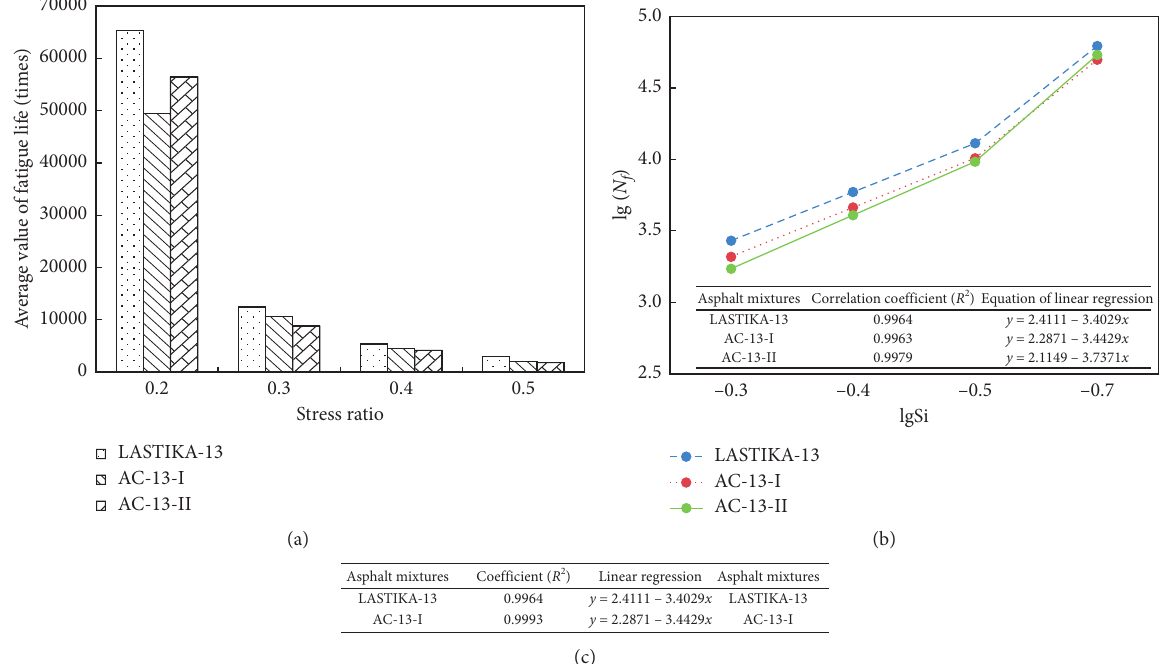
Figure 10: Fatigue life resistance of asphalt mixtures with different gradations: (a) Fatigue life results of asphalt mixtures with different gradations; (b) Fatigue Life and Linear Regression of Asphalt Mixtures; (c) The linear regression of fatigue life of asphalt